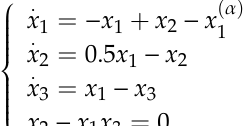
Figure 5. Percentage difference of x 3 between the exact solutions and the present method for different time steps h .